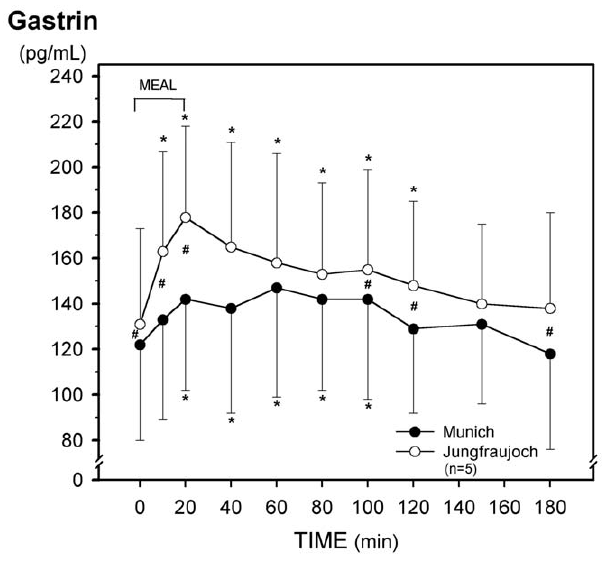
Figure 2. Effect of acute exposure to high altitude (Munich, 490 m, to Jungfraujoch, 3454 m) on postprandial plasma levels of gastrin. Asterisks (*) indicate a significant increase (p , 0.03) as compared with the preprandial values at 0 min and crosses ( # ) mean a significant (p , 0.03) difference between the respective values at the two sea levels.